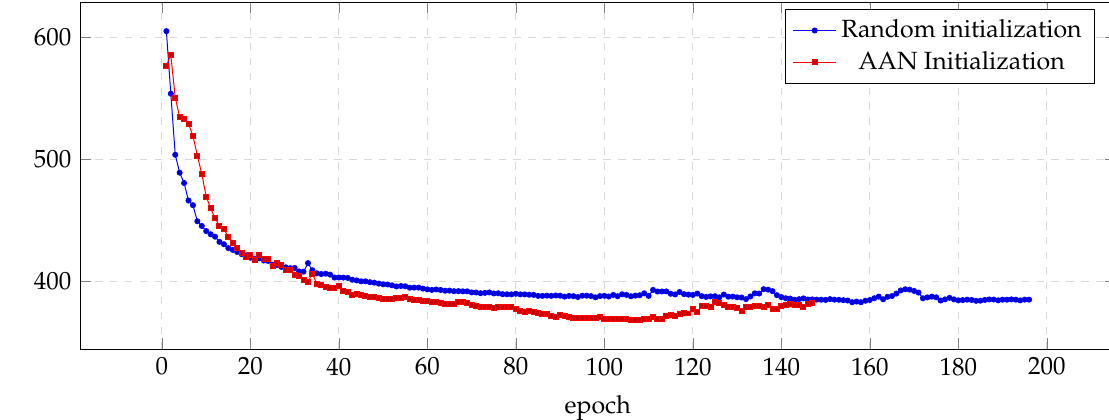
Figure 4. Evolution of the sse value for the validation set during the training process of the RMS